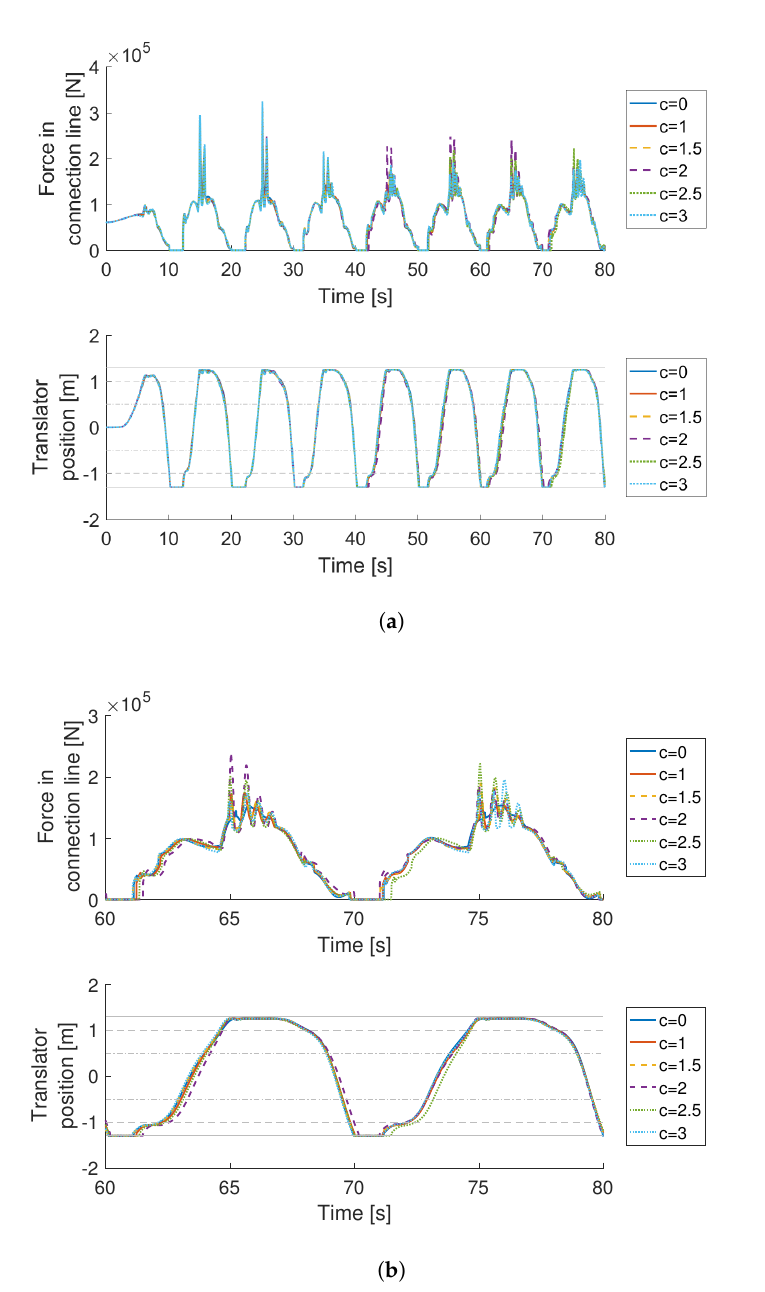
Figure 15. The simulated force in the line of the wave power unit as well as translator position for different values of c used in the simulation; for the whole simulation, which goes from 0 to 80 s of simulated waves ( a ) and zoomed in from 60 to 80 s ( b ) in order to visualize the differences for different values on c